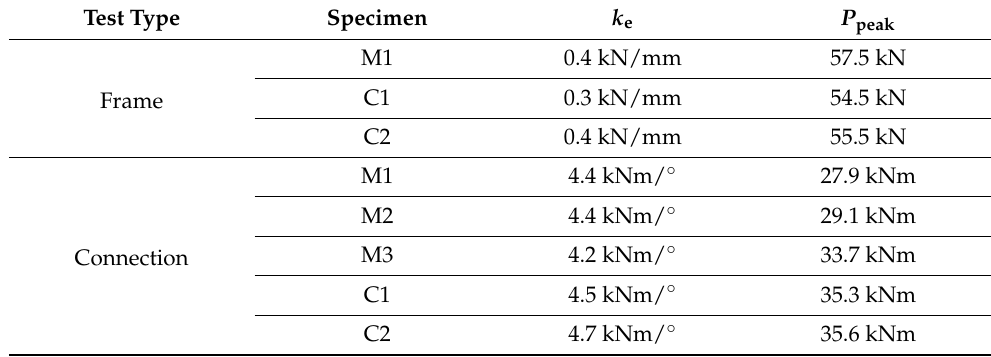
Table 3. Mechanical parameters for the frame and connection tests (Adapted from Ref.